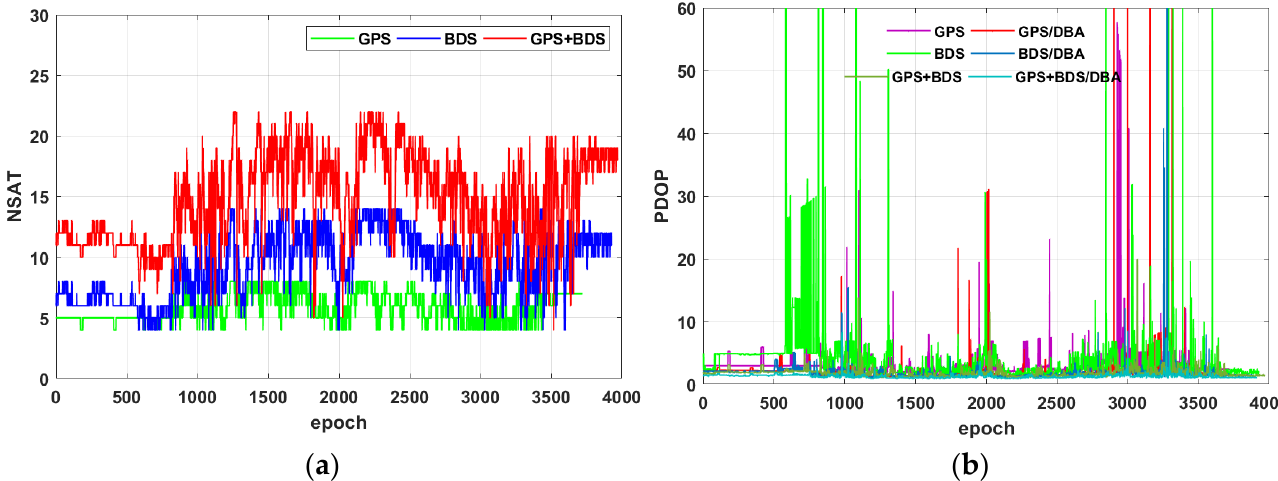
Figure 17. Observation values of kinematic vehicle experiment in the complex urban environment: ( a ) number of GNSS visible satellites; ( b ) sequence of PDOP values. ( a ) number of GNSS visible satellites; ( b ) sequence of PDOP